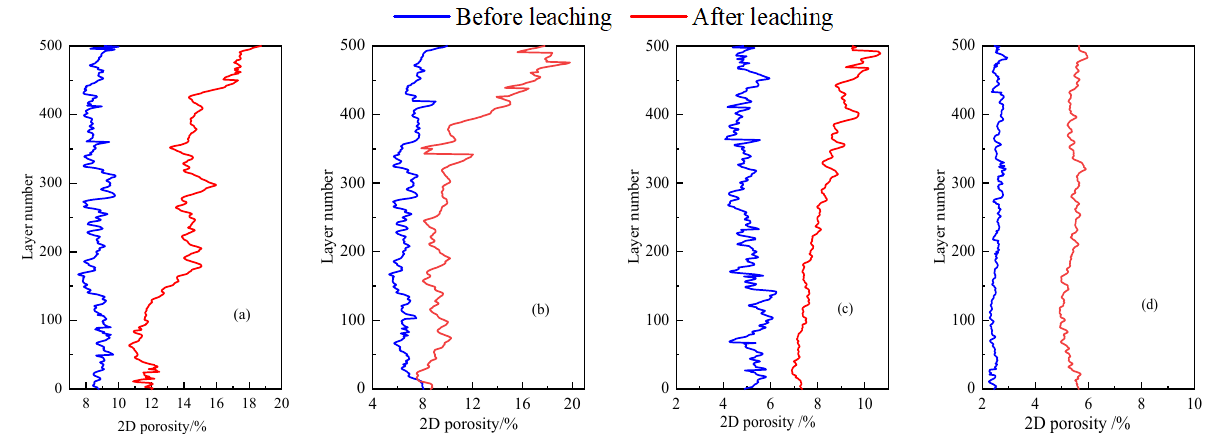
Figure 11. Two-dimensional porosity of ore samples in the vertical direction. ( a ) A D = 2 . 03 ; ( b ) B D = 2 . 23 ; ( c ) C D = 2 . 43 ; ( d ) D D = 2 . 63 .